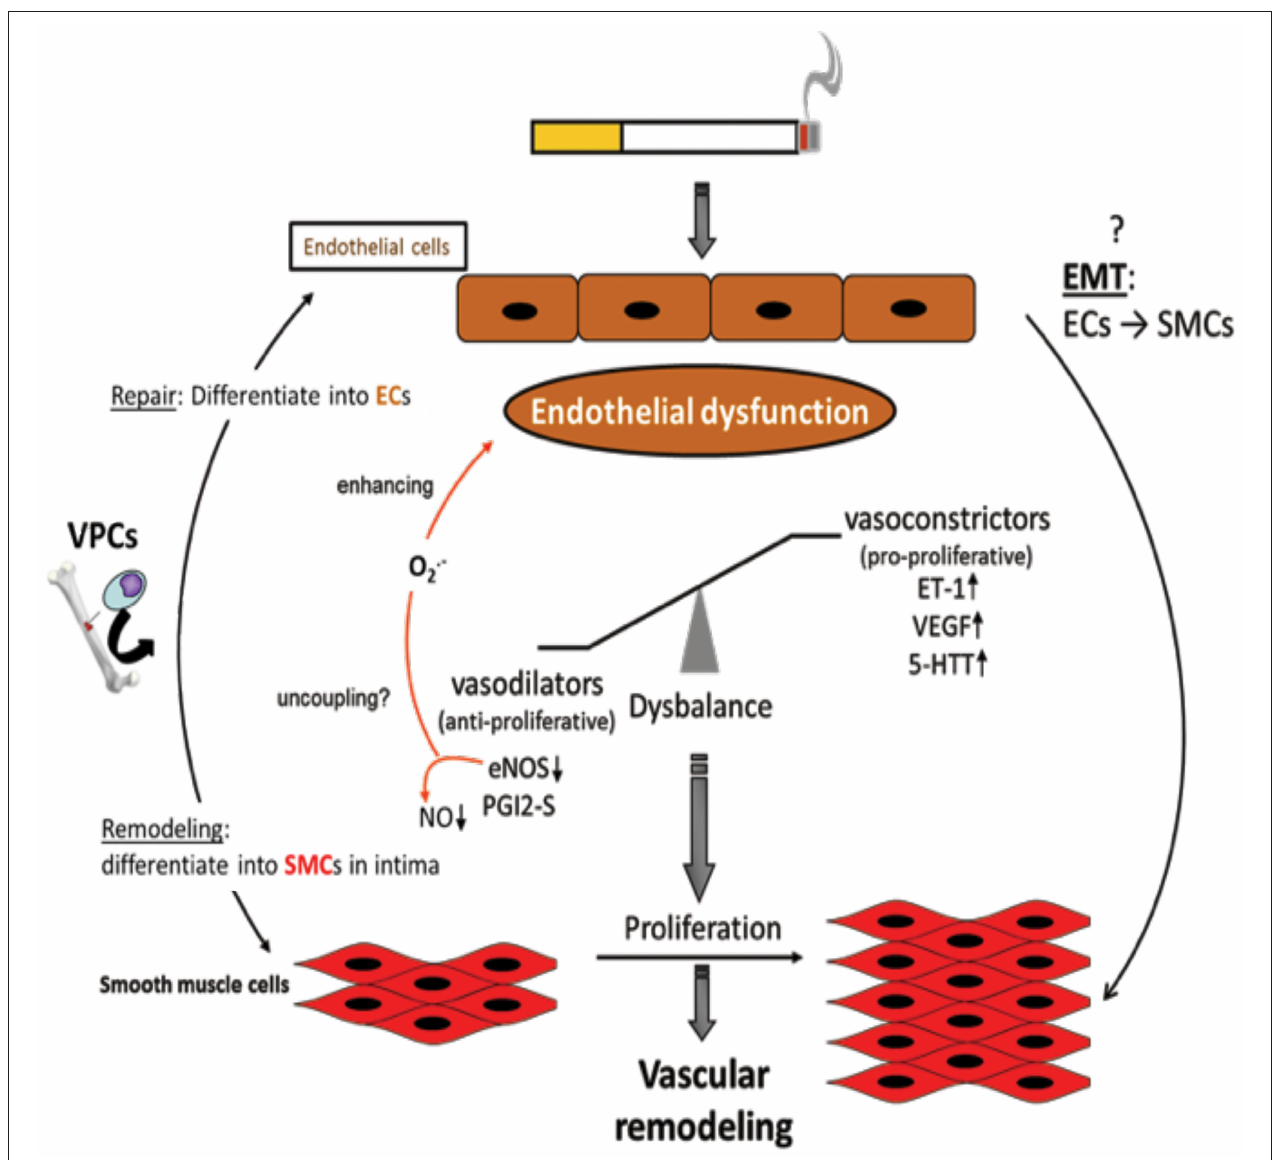
FIGURE 3 | Endothelial dysfunction as causing factor for development of vascular remodeling. Cigarette smoke and inflammatory mediators can cause endothelial dysfunction which is triggered by a disbalance of vasodilative and vasoconstrictive molecules towards an excess of vasoconstrictors and damage/dysregulation of EC signaling. Additionally, vascular progenitor cells (VPCs) are attracted to the damaged endothelium. Such VPCs can either contribute to repair by differentiation into ECs or to remodeling by differentiation into SMCs. Furthermore, an endothelial-to-mesenchymal-transition (EMT) may occur resulting in an SMC phenotype. Vasoconstriction and altered endothelial cell signaling are stimuli for SMCs to proliferate resulting in vascular remodeling, increased pulmonary artery pressure, and finally in pulmonary